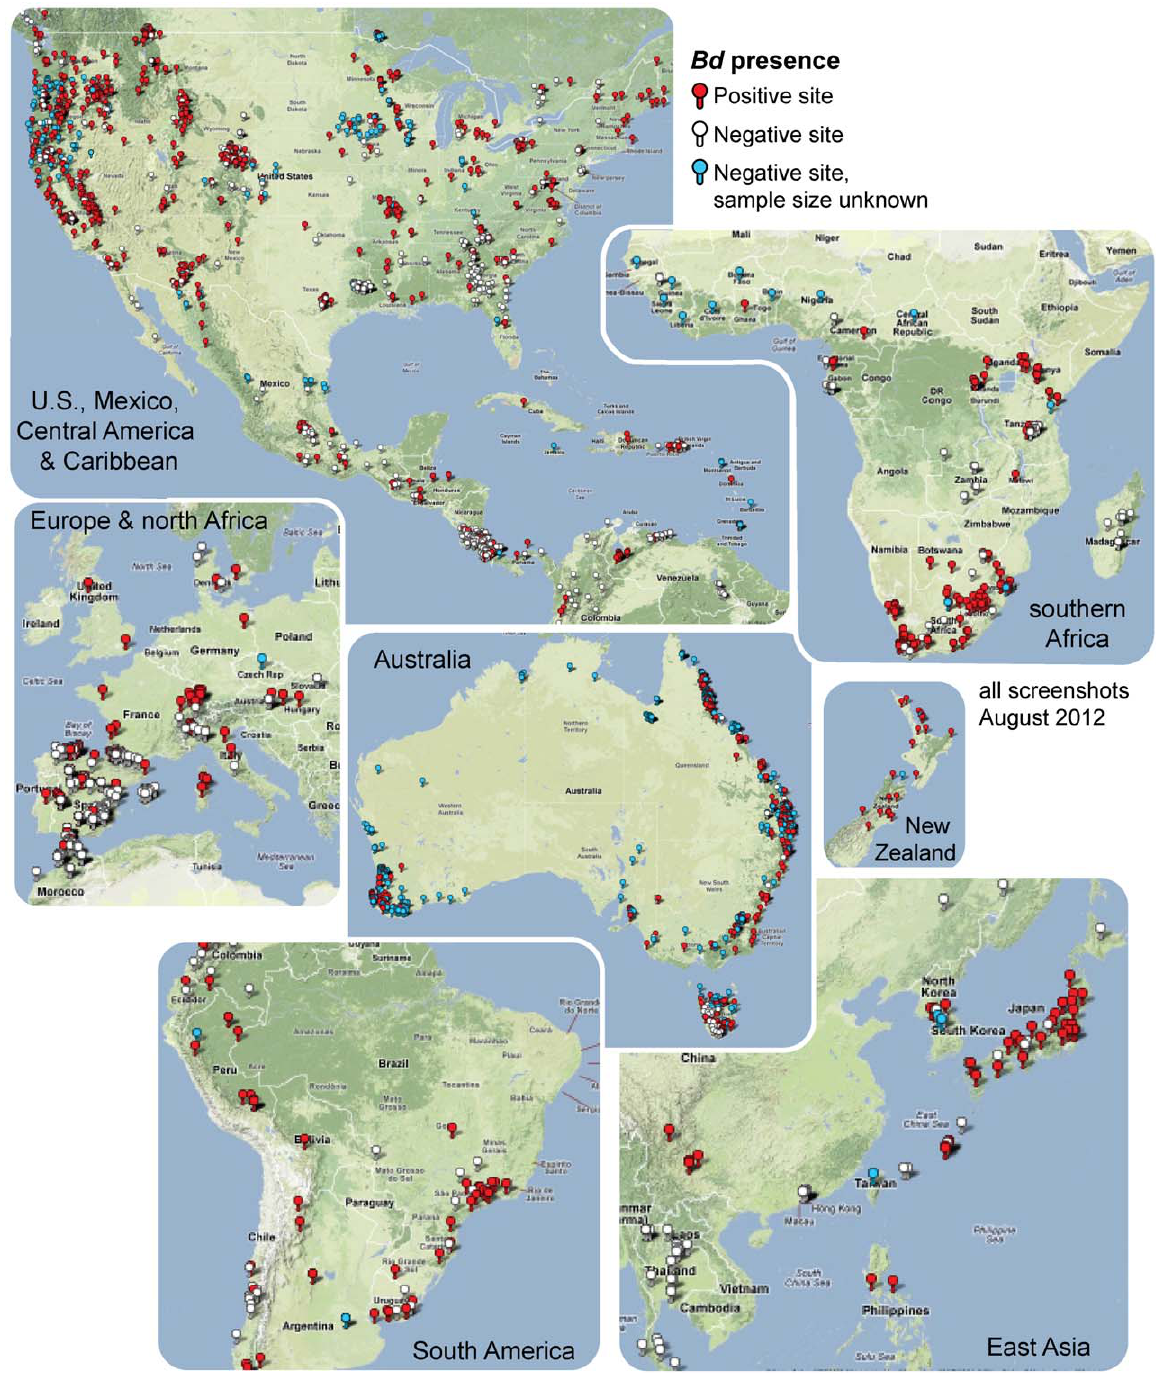
Figure 1. Global distribution of the amphibian chytrid fungus, Batrachochytriumdendrobatidis ( Bd ). Maps downloaded from www.Bd- maps.net (15 August 2012); Bd -positive (red) and Bd -negative (white, blue) sites are shown.